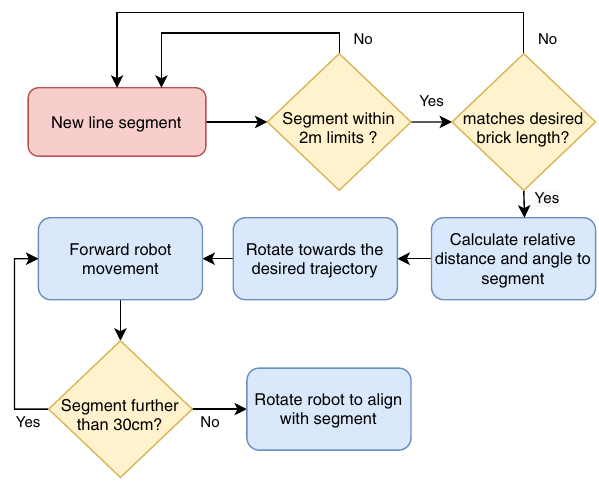
Fig. 9 Flowchart describing the laser-based brick alignment rou-